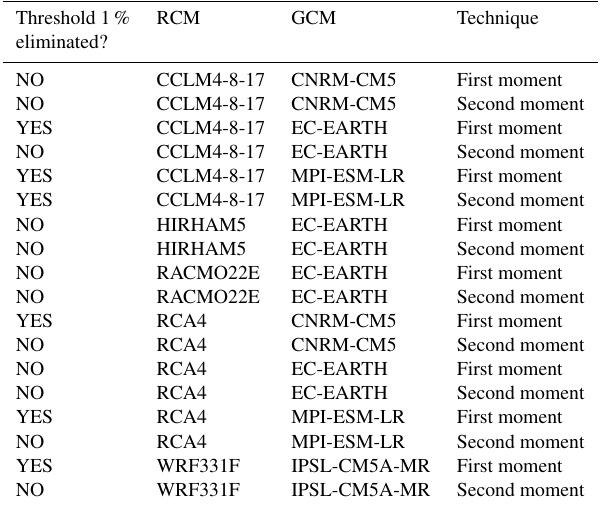
Table 3. Eliminated and non-eliminated combinations of model and bias-correction